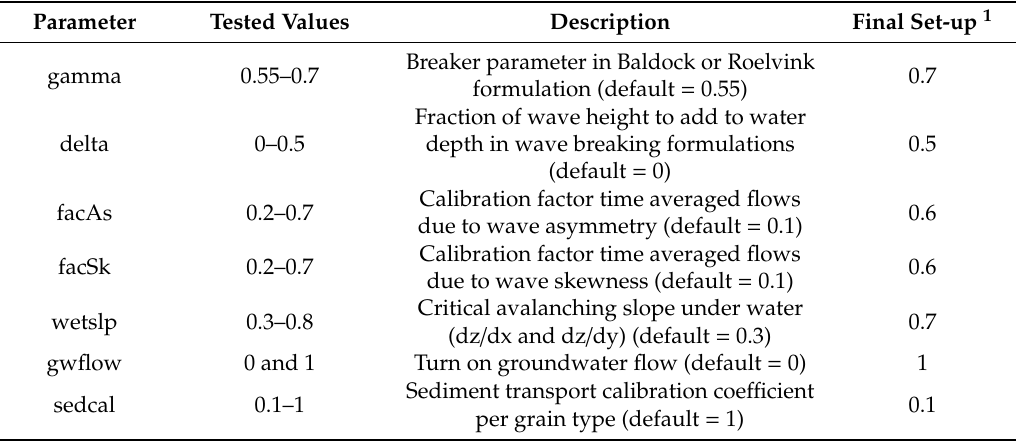
Table 1. Calibration parameters. Range of tested values and final parameter setup.